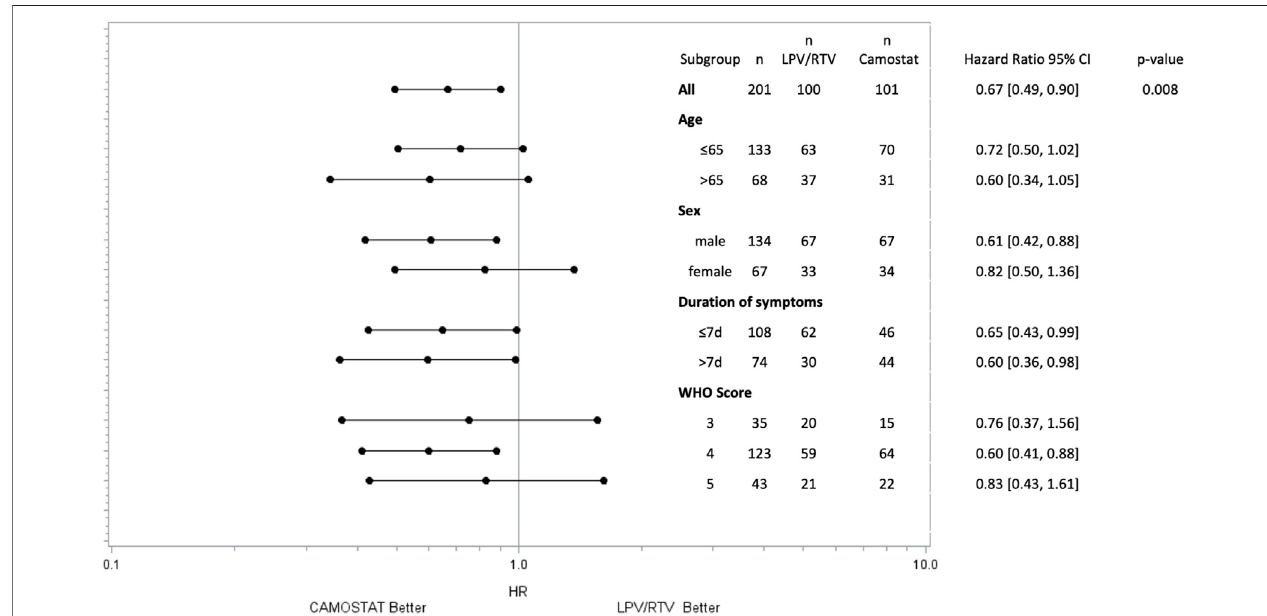
FIGURE 2 | Time to sustained ( ≥ 48 h) improvement ≥ 1 point in the WHO scale by subgroups. p -values for subgroups are not displayed as the study was not powered for this analysis.